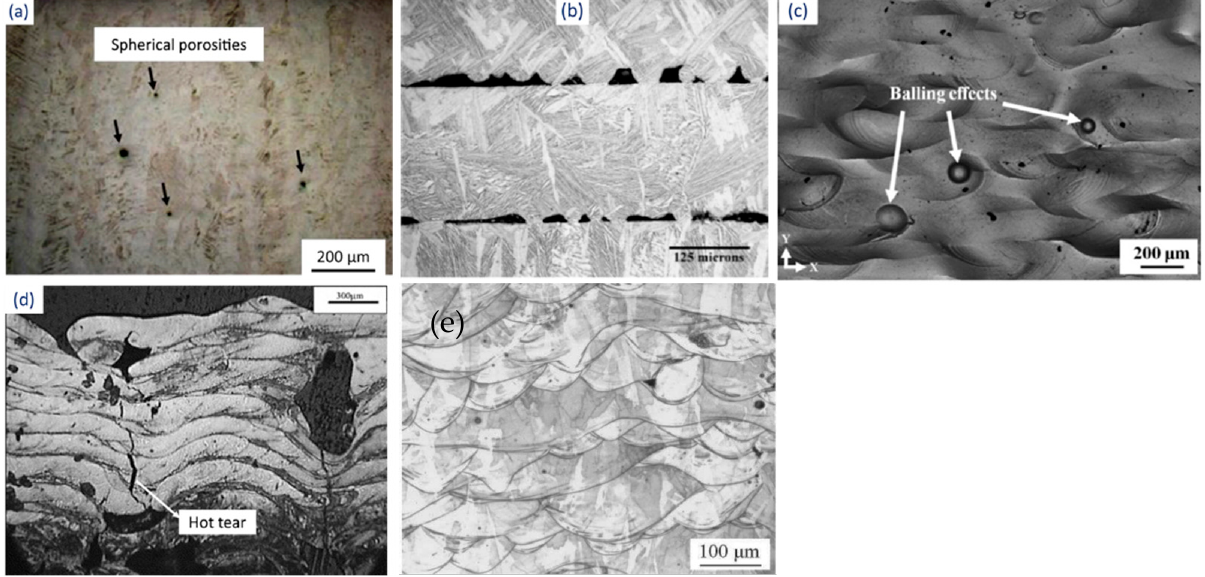
Figure 8. Defects generated during the SLM process: ( a ) porosity [135], ( b ) inadequate fusion between layers [136], ( c ) balling effect [137], ( d ) hot tear [133], and ( e ) fish scaling